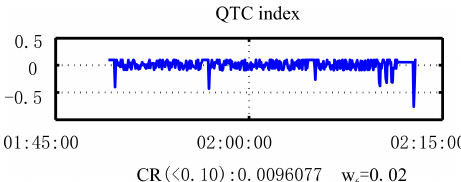
Figure 15. QTC index of the actual